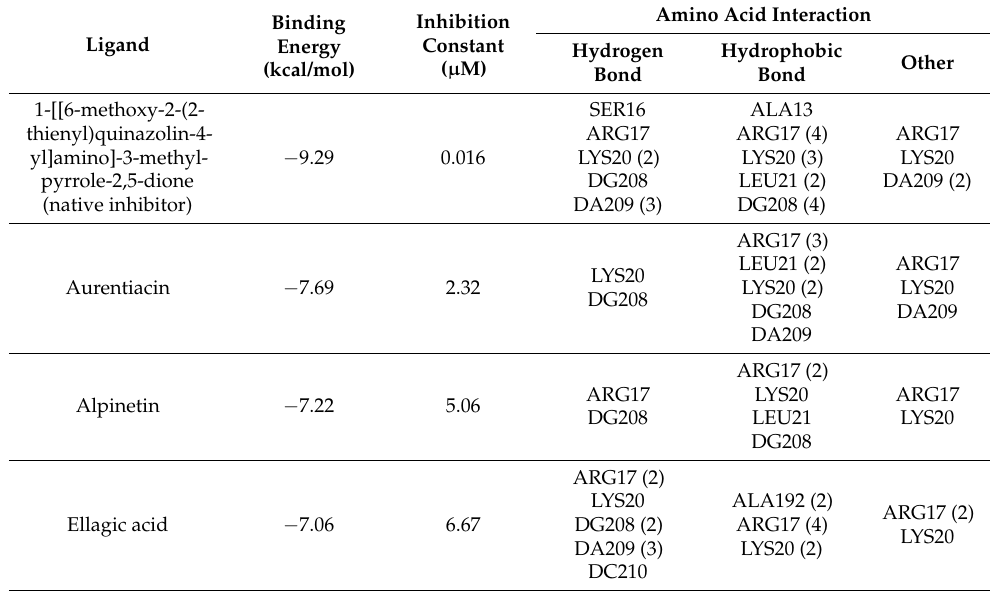
Figure 2. Schematic interactions of amino acid residues between reference inhibitor or candidate compounds and NF-κB protein. The original inhibitor of NF-κB protein is ( A ) 3,5-dimethyl-4-[(2- nitrophenyl)diazenyl]pyrazole-1-carbothioamide and candidate ligands are as follows: ( B ) alpinetin, ( C ) aurentiacin, ( D ) brassitin, ( E ) ellagic acid, and ( F ) ferulic acid. The green dashed line represents hydrogen, the pink or purple dashed lines represent hydrophobic bonds, and the yellow dashed line indicates other bonds. Table 2. Molecular docking results of top 5 identified compounds to AP-1 binding site .